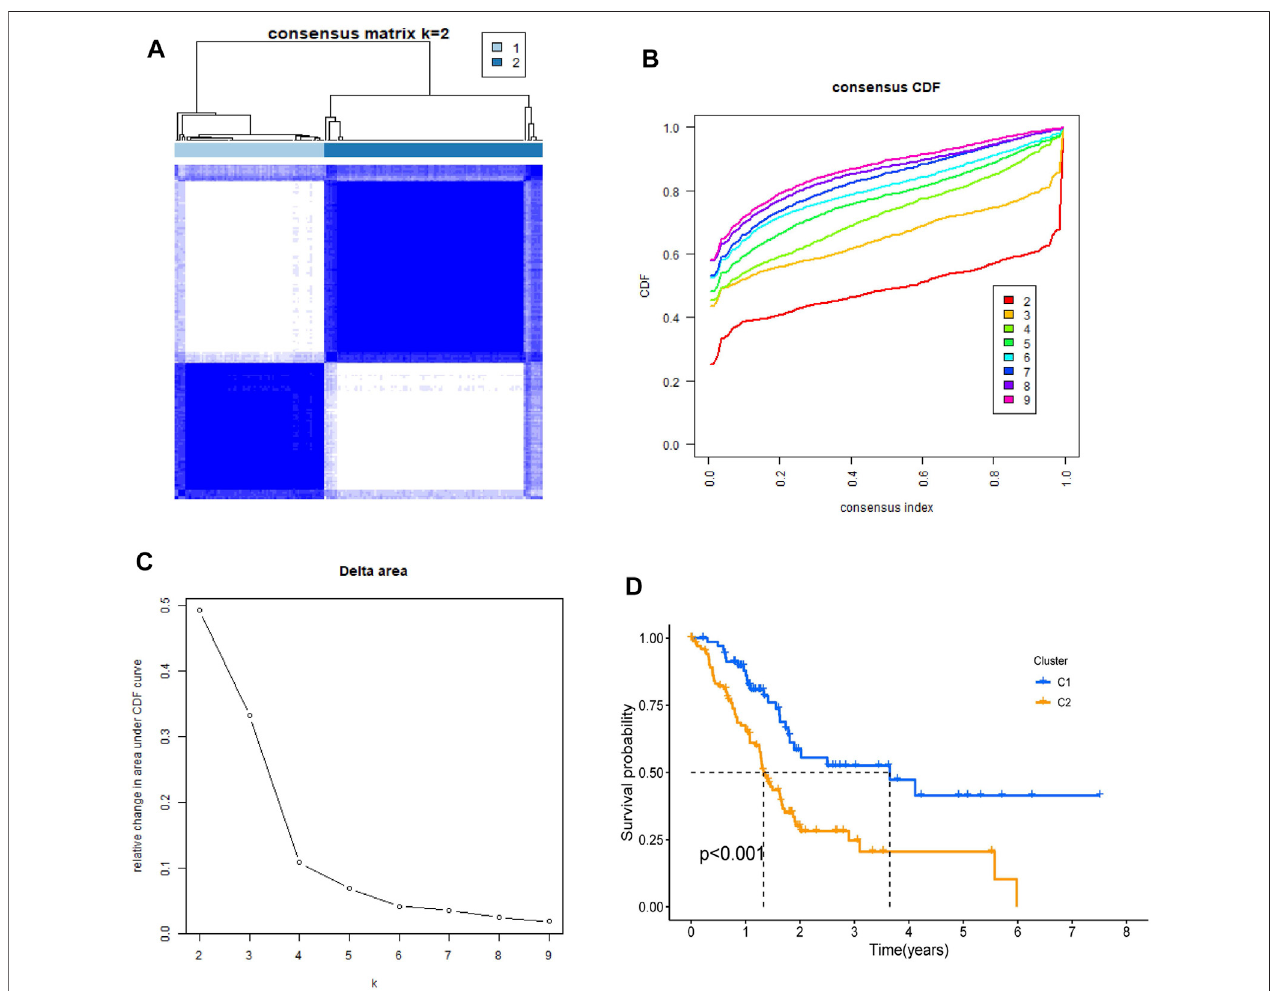
FIGURE 3 | Identi fi cation of tumor classi fi cation based on the NRGs. (A) PDAC patients were classi fi ed into two clusters by NRGs-based consensus clustering analysis (k = 2). (B,C) Cumulative Distribution function (CDF) consistent clustering model with k from 2 to 9. (D) Kaplan – Meier survival analysis in two clusters.